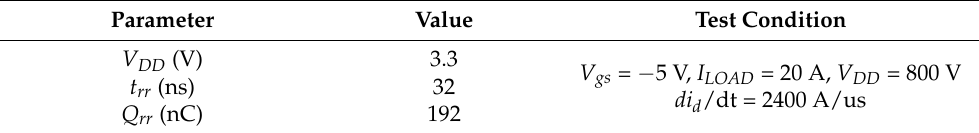
Table 1. Antiparallel Freewheeling Diode Characteristics and Reverse Recovery Test Parameters.